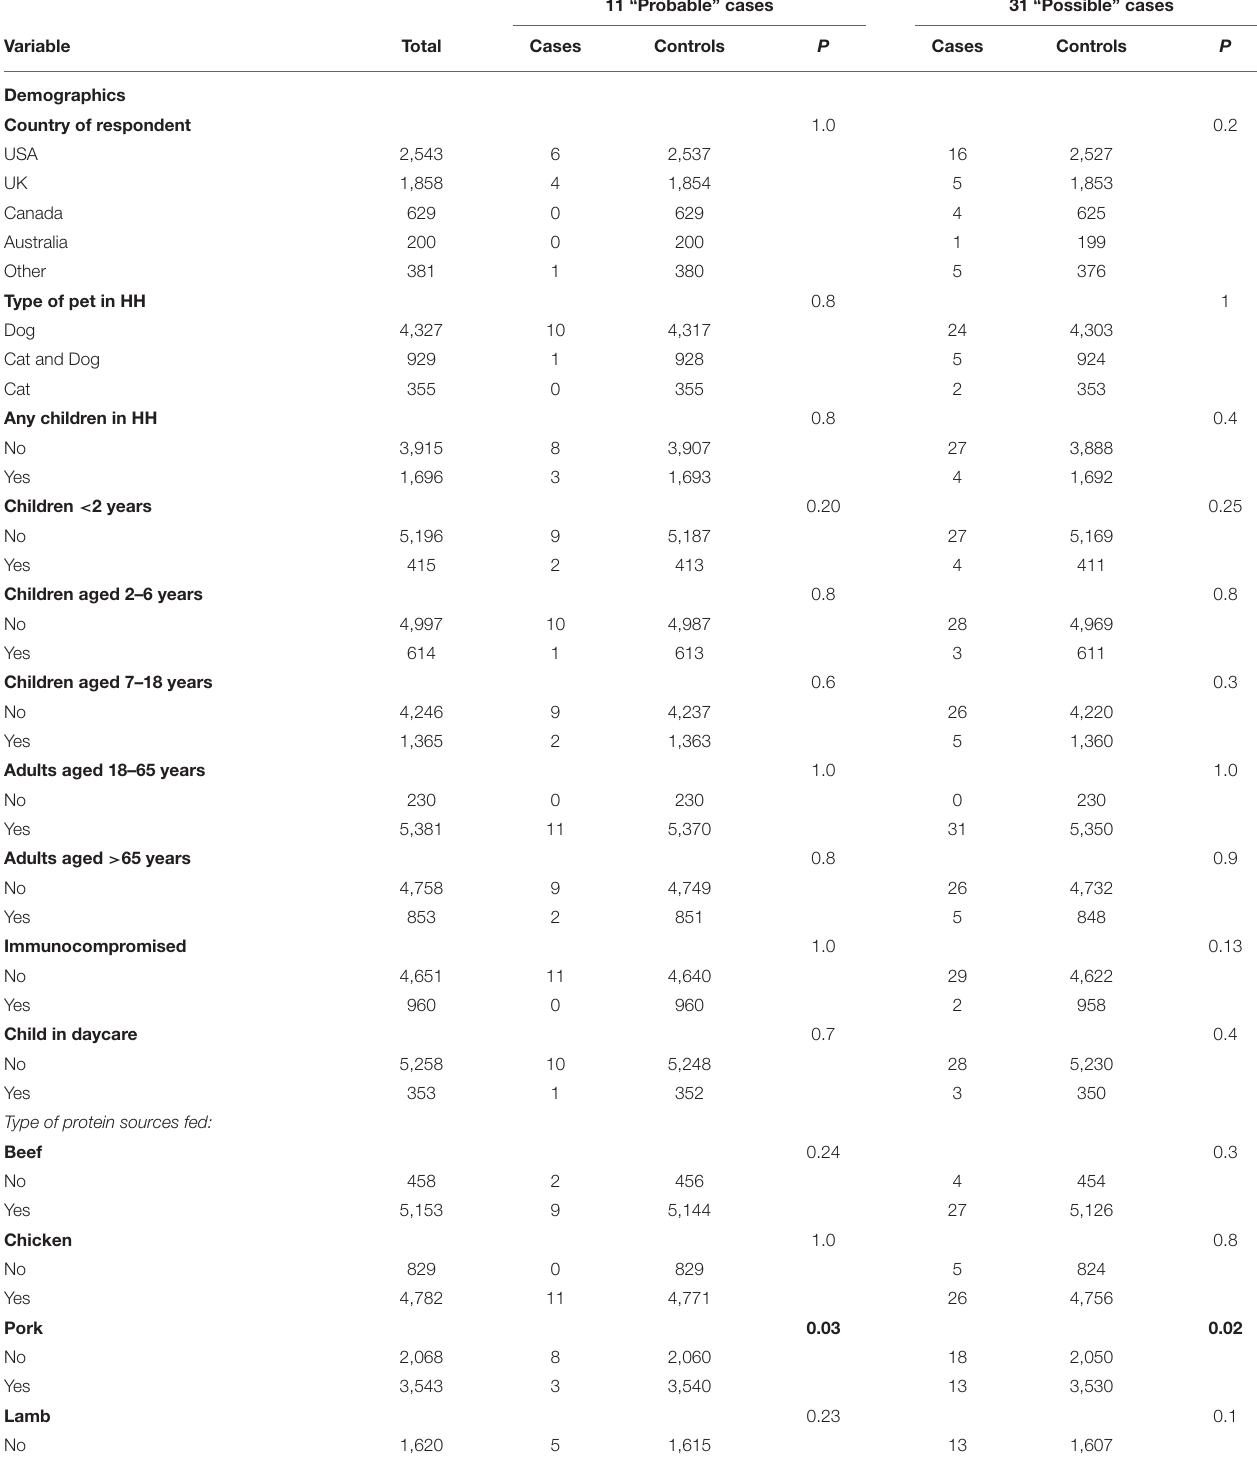
TABLE 3 | Results of 2 sets of univariable logistic regression showing the potential independent predictor variables for the 11 “probable” cases of household transmission with 5,600 controls as well as a total of 31 cases (11 “probable” cases plus 20 “possible” cases) of household transmission with 5,580 controls with numbers and p -values reported as with numbers and P -values ( P ) for categorical variables and as median values with interquartile range (IQR) and minimum (min) and maximum (max) values and P -values ( P ) for continuous